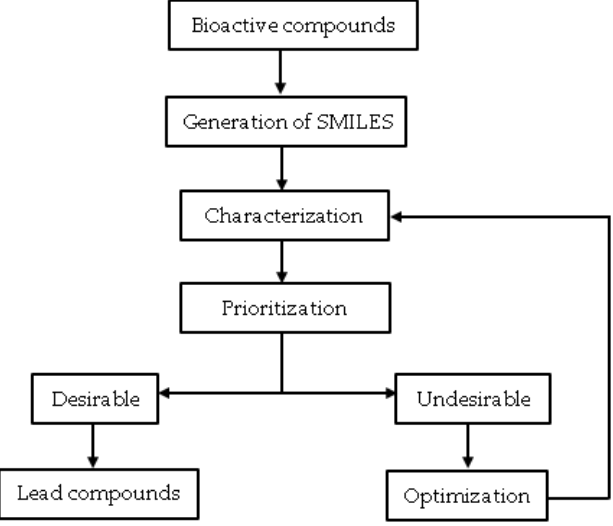
Figure 1. The overall methodology of cheminformatics application in lead discovery.